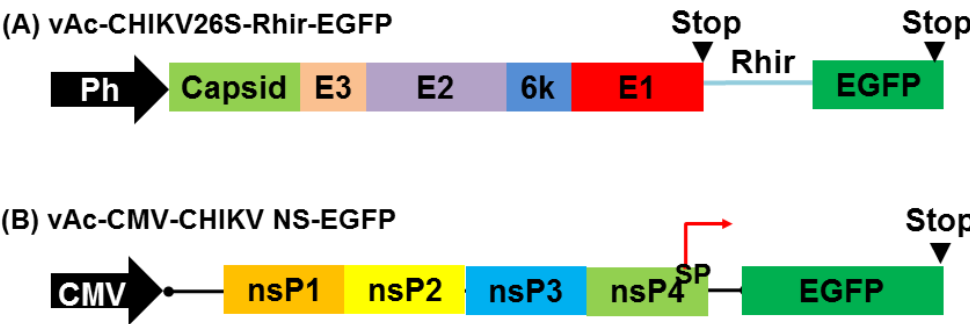
Figure 1. Schematic presentation of the recombinant baculovirus transfer vector and BacMam vector used in this study. ( A ) vAc-CHIKV26S-Rhir-EGFP is a baculovirus that expresses CHIKV structural proteins controlled by Ph promoter. ( B ) vAc-CMV-CHIKV NS-EGFP BacMam vector contain human cytomegalovirus immediate early promoter (CMV) to control the expression of CHIKV non-structural protein and the reporter gene EGFP controlled by subgenomic promoter. (Abbreviations: Ph, polyhedrin promoter; EGFP, enhanced green fluorescent protein gene; Rhir, RhPV 5 ′ -UTR IRES; STOP, translational stop codon, CHIKV structural proteins (Capsid, E3, E2, 6k and E1); CHIKV non-structural proteins (nsP1 – 4); and SP, subgenomic promoter).